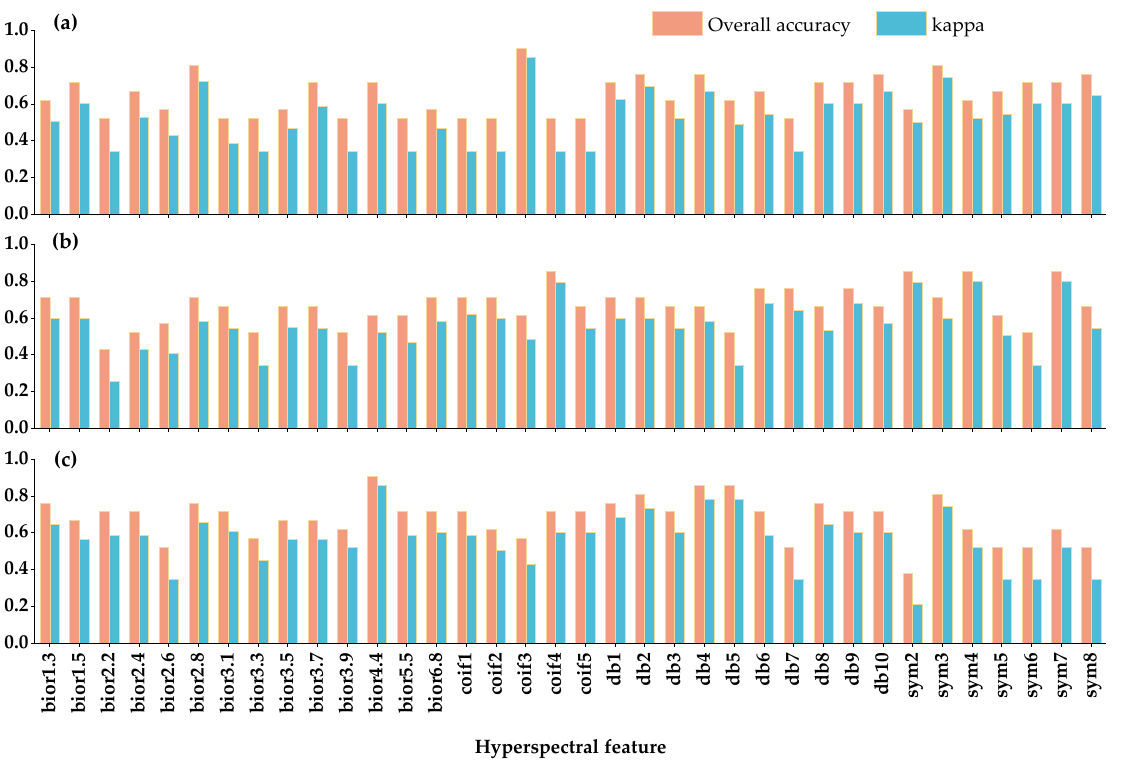
Figure 6. Accuracies of early pest discrimination models based on ( a ) chlorophyll content, ( b ) fresh weight moisture content, and ( c ) dry weight moisture content.